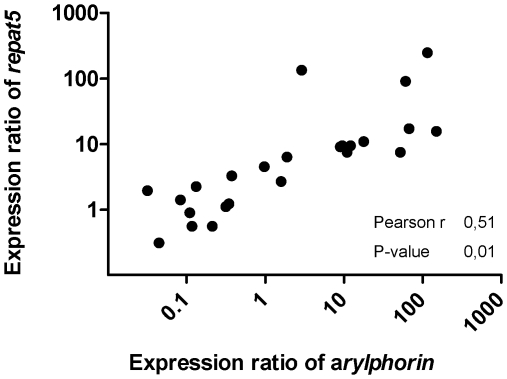
Correlation analysis of repat5 and arylphorin genes.Correlation analysis between the expression ratio of repat5 and arylphorin in individual larvae from the Xent-RU colony (Pearson r and p-value are shown).